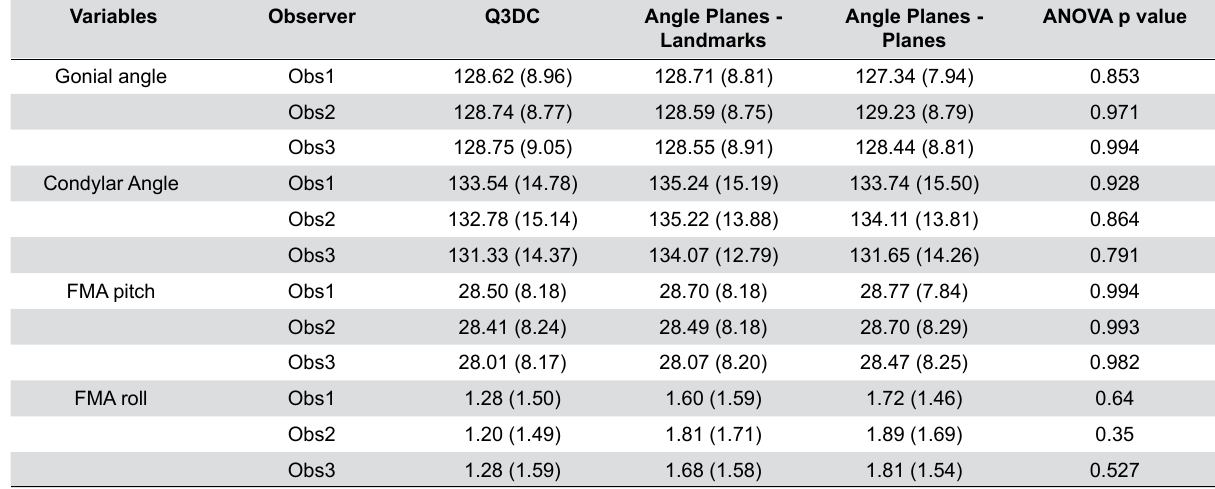
Table 2- Mean, standard deviation and ANOVA results comparing the 3 methods for each Variables